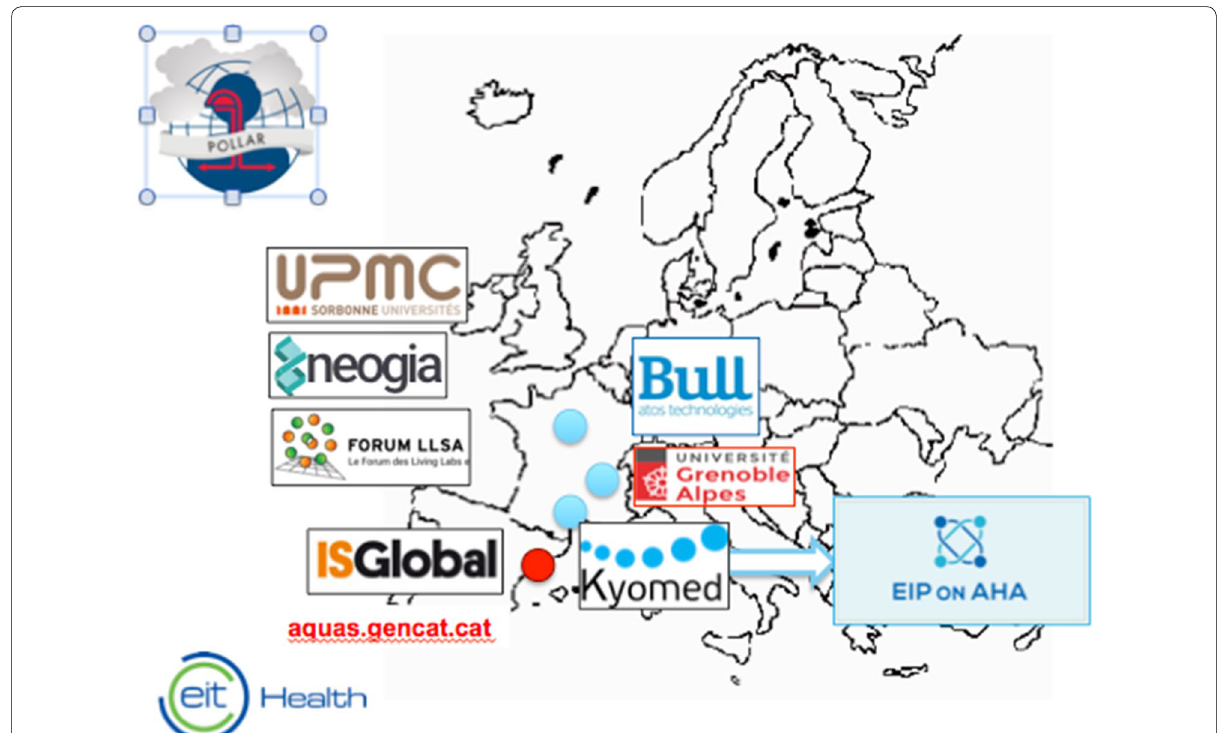
Fig. 2 The POLLAR